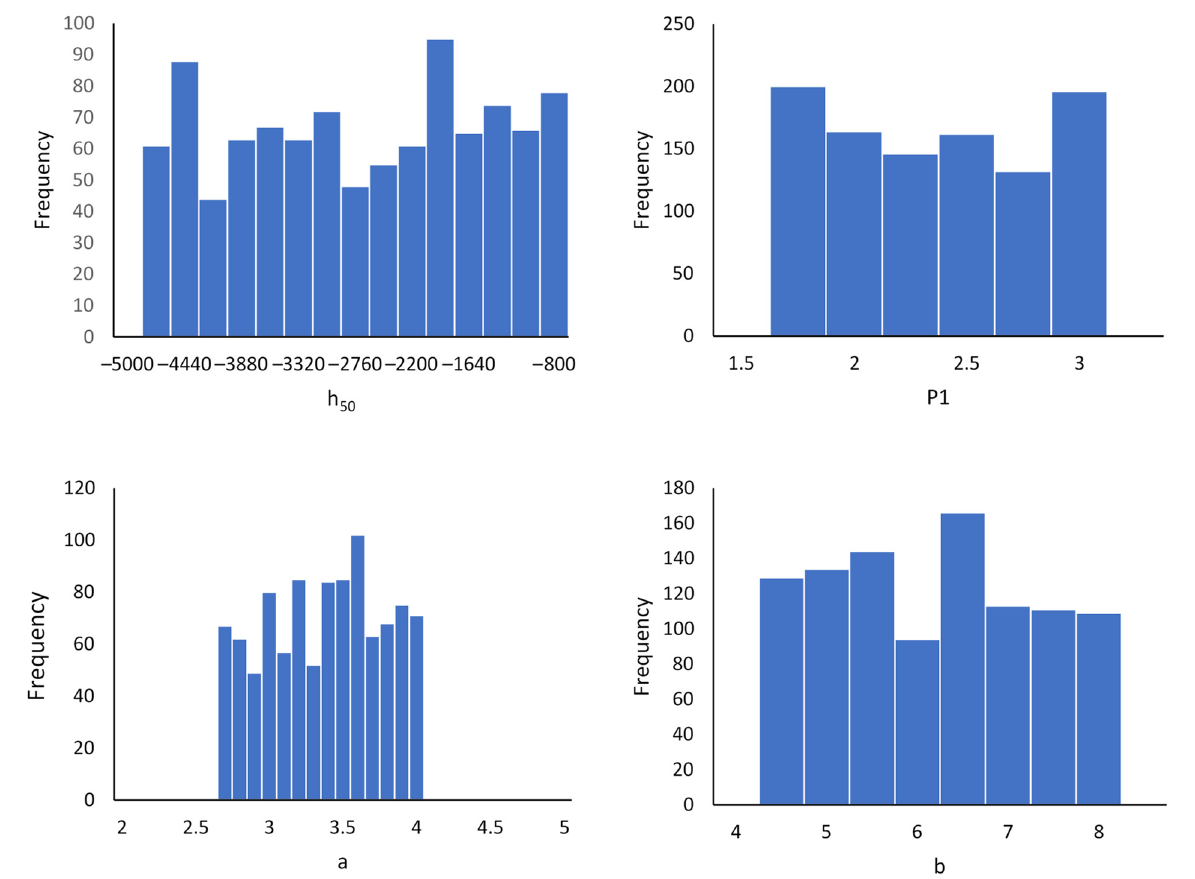
Figure 4. Posterior distributions of the root water uptake parameters.